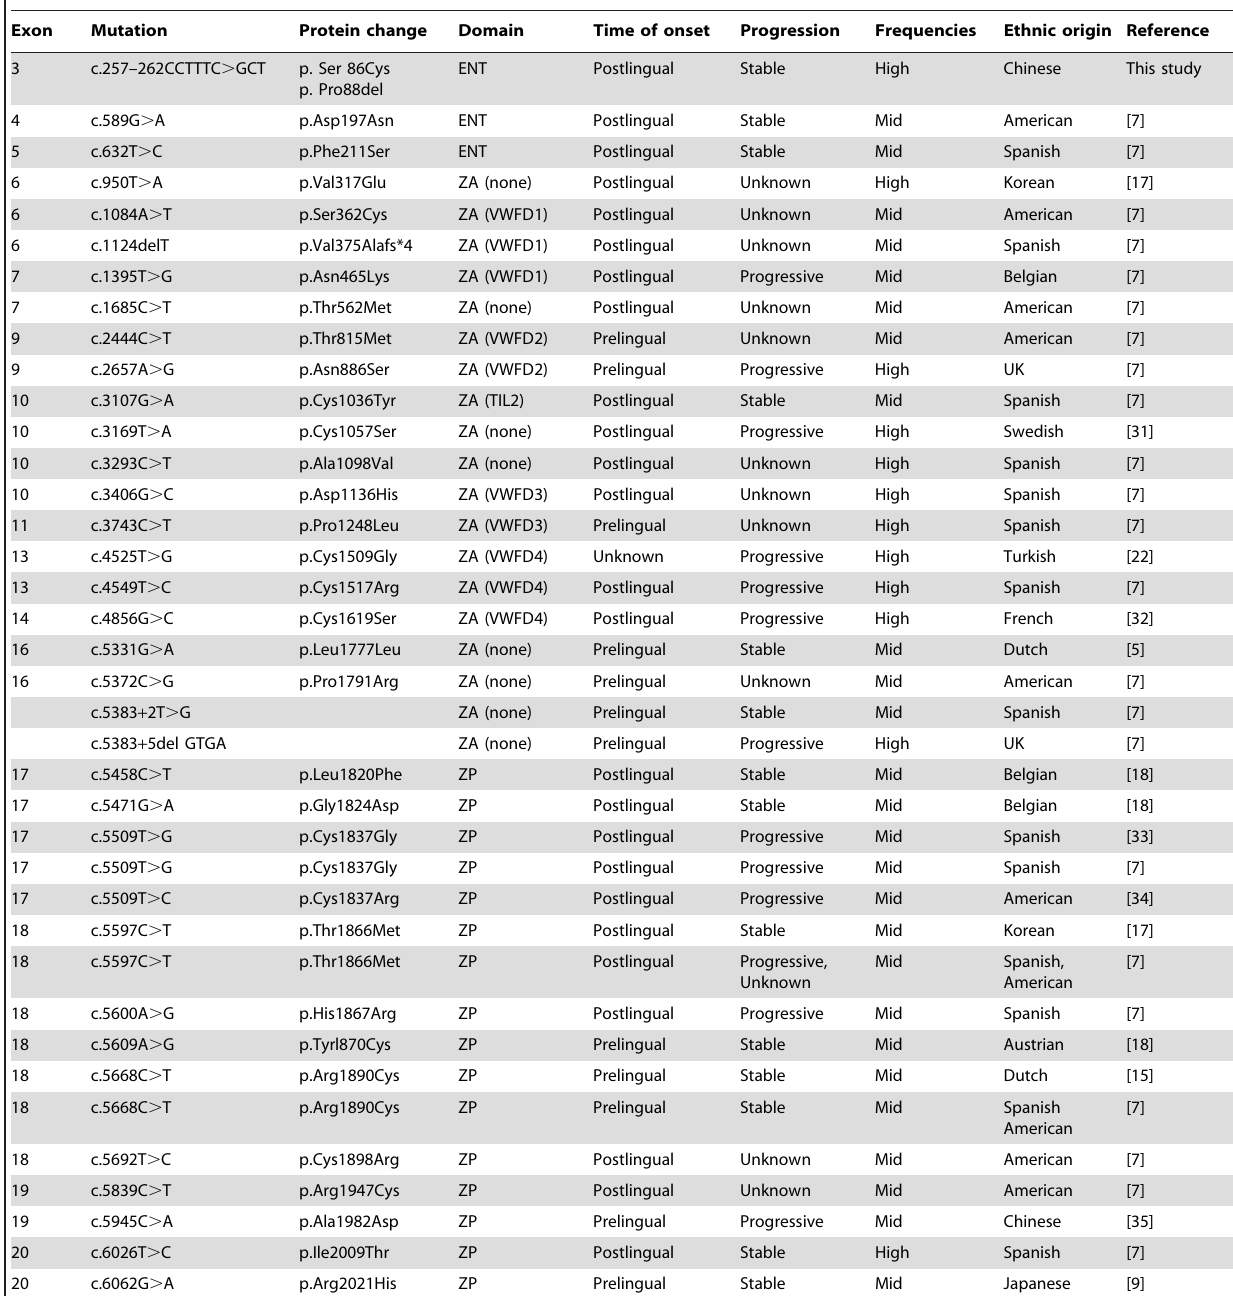
Table 1. TECTA mutations described in DFNA8/12 families, including those identified in this study.